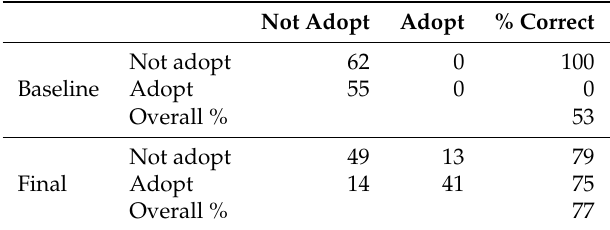
Table 6. Correct prediction results.